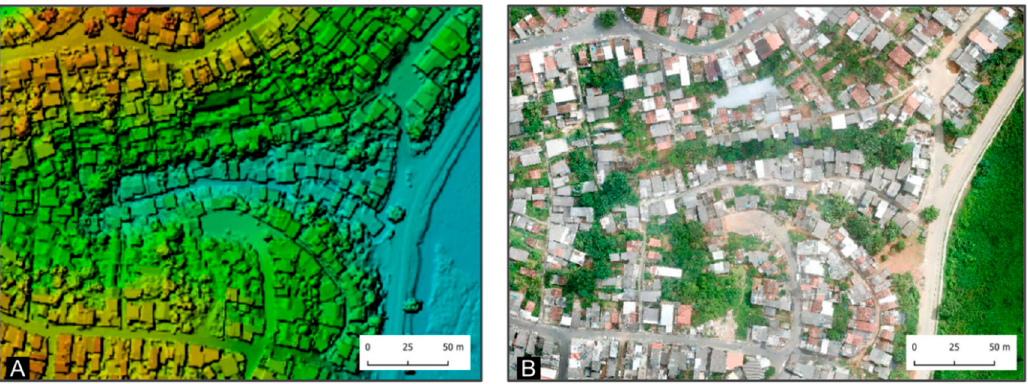
Figure 7. Fragments of the ( A ) digital elevation model and ( B ) orthophoto of Alto do Cabrito.